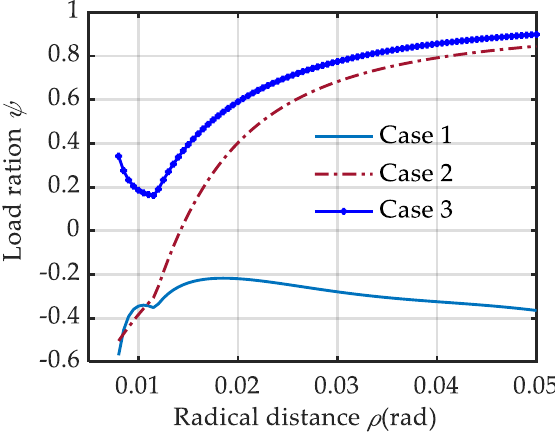
Figure 8. Stiffness resolution based on different cases.